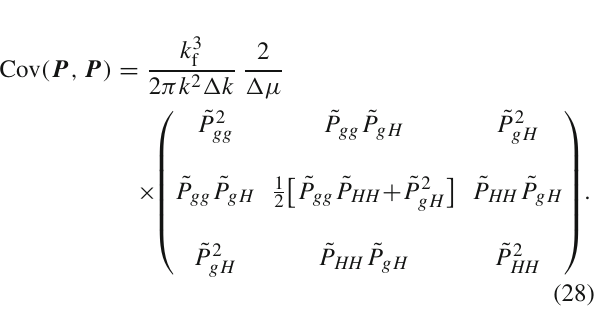
The covariance for the multi-tracer power spectra is